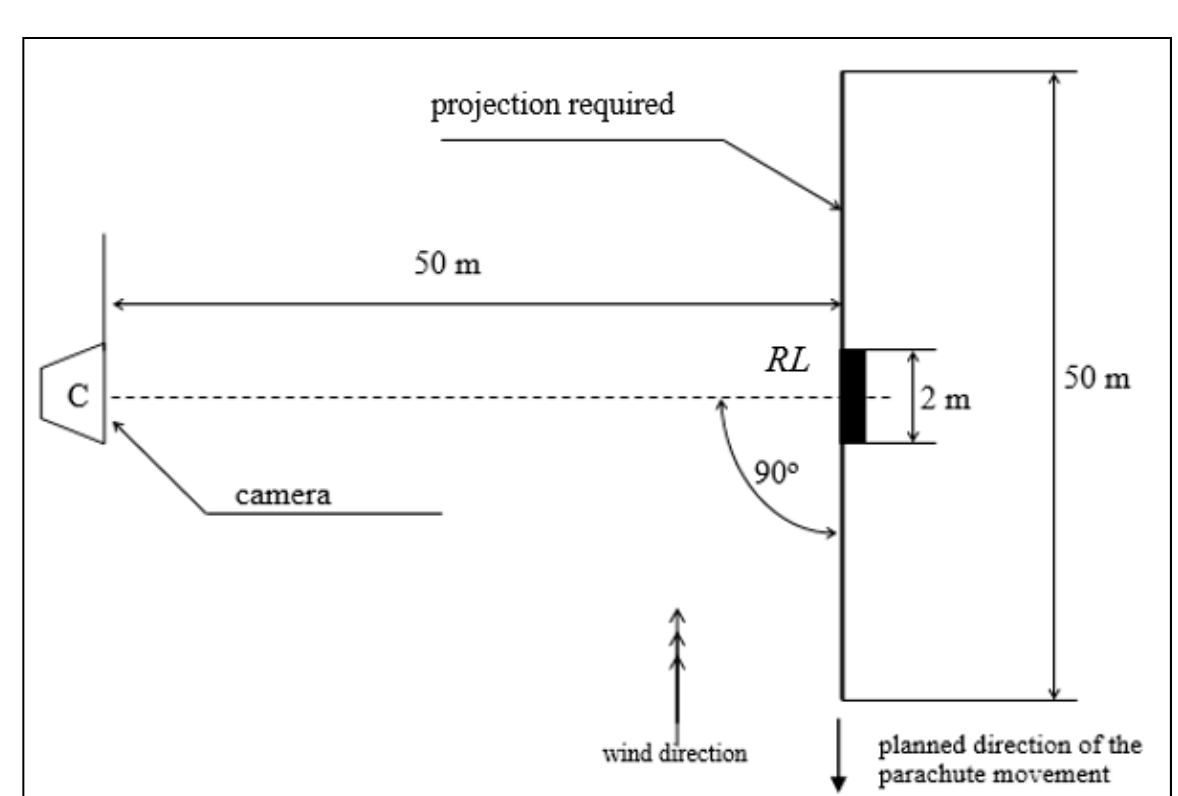
Figure 4. Basic scheme for reference length (RL) scanning—view from above (source: The authors of this article).